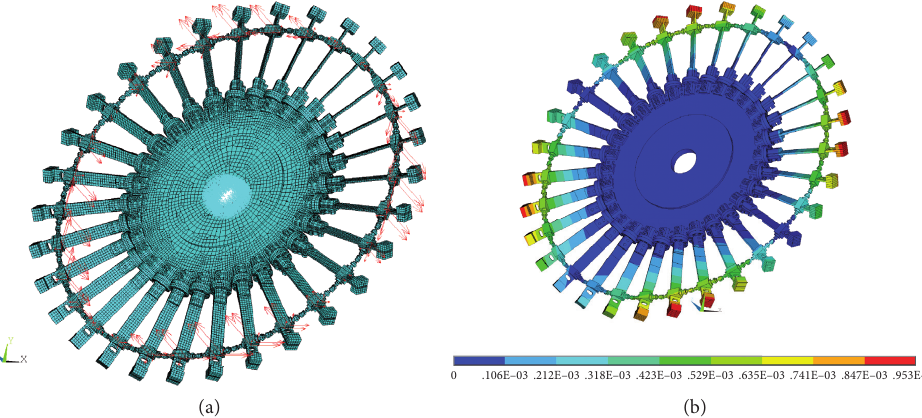
Figure 11: (a) Distribution of modal forces around the wheel (red vector). (b) Contour maps of initial displacements (m) of the wheel—2ND mode.